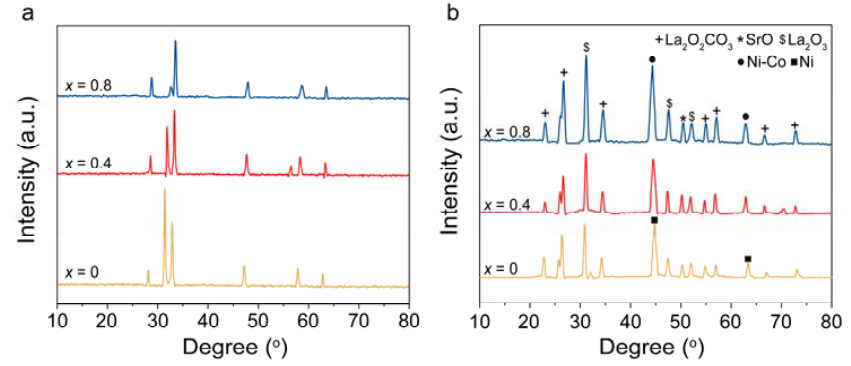
Figure 2. XRD profiles of ( a ) fresh oxygen carriers and ( b ) reduced oxygen carriers. Table 3. Relationship between oxygen carrier and d spacings of Ni or Ni-Co alloy (111) planes at 2 θ = 44.20 ◦ –44.70 ◦ after reduction.